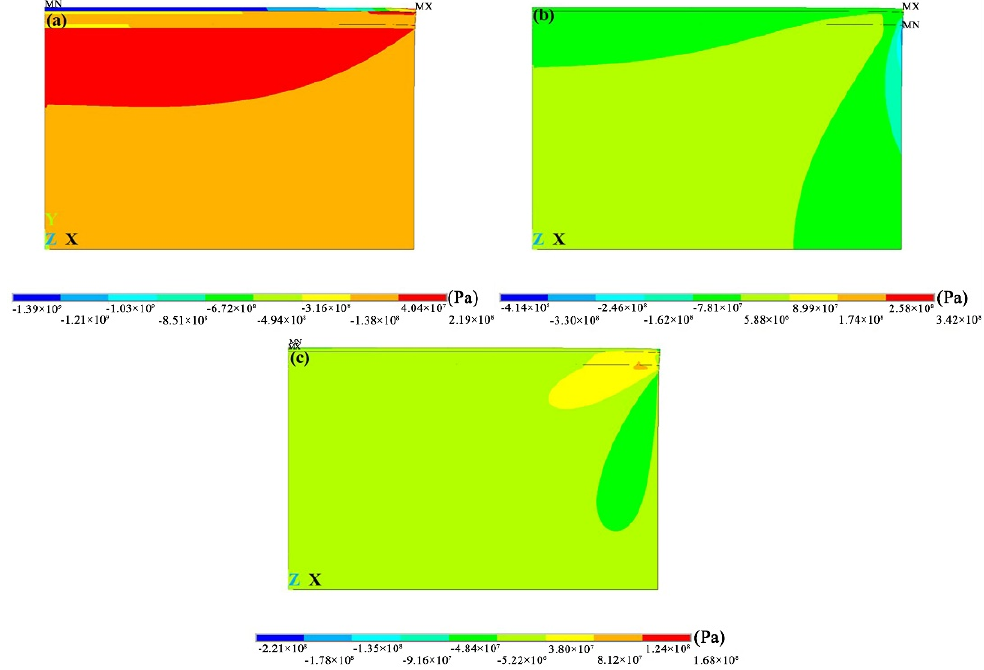
Figure 4. Contour plot of the residual stress when the coating was cooled to room temperature from high temperature: ( a ) radial stress; ( b ) axial stress and ( c ) shear stress.